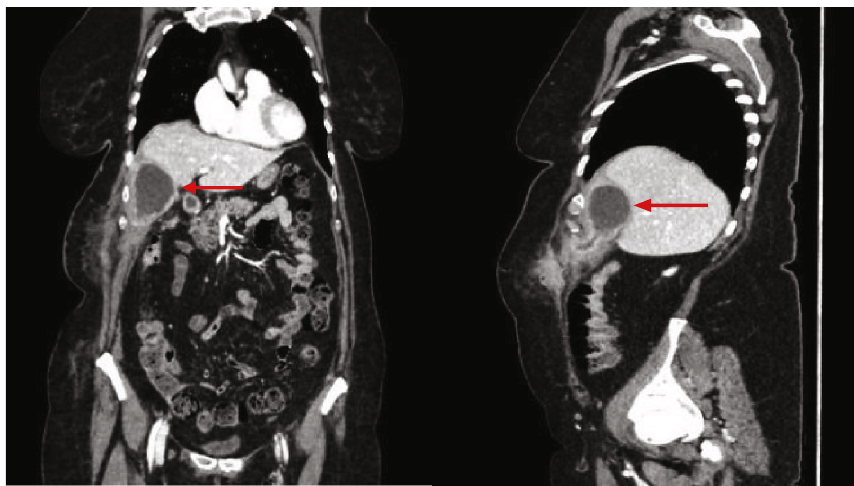
Figure 1: Abdominal computed tomography (CT) with the presence of a subparietal fl uid collection of the right hypochondrium ( 40 × 45 × 65mm